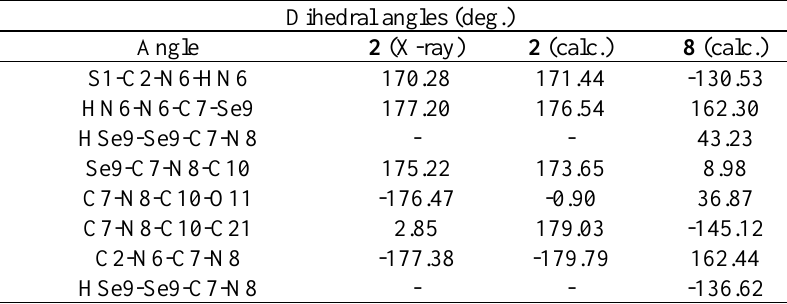
Table 3. Selected dihedral angles in 2 and 8